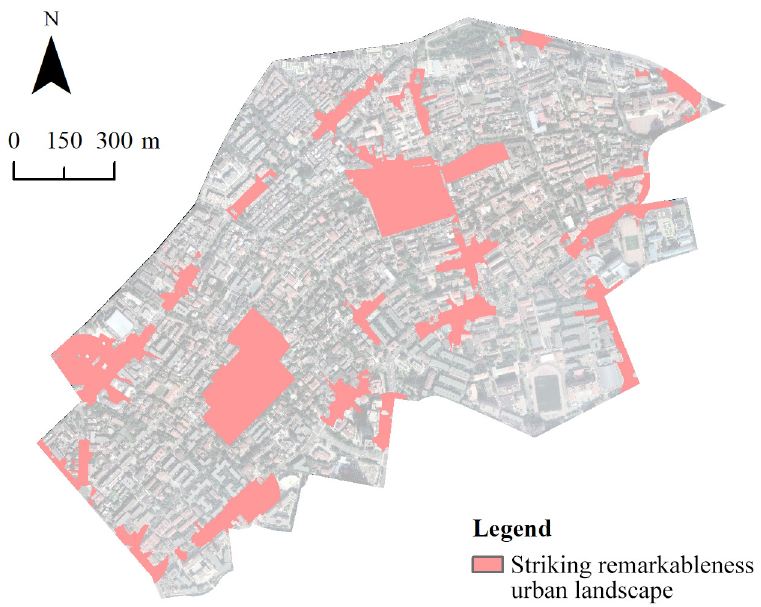
Figure 8. Distribution of remarkable urban